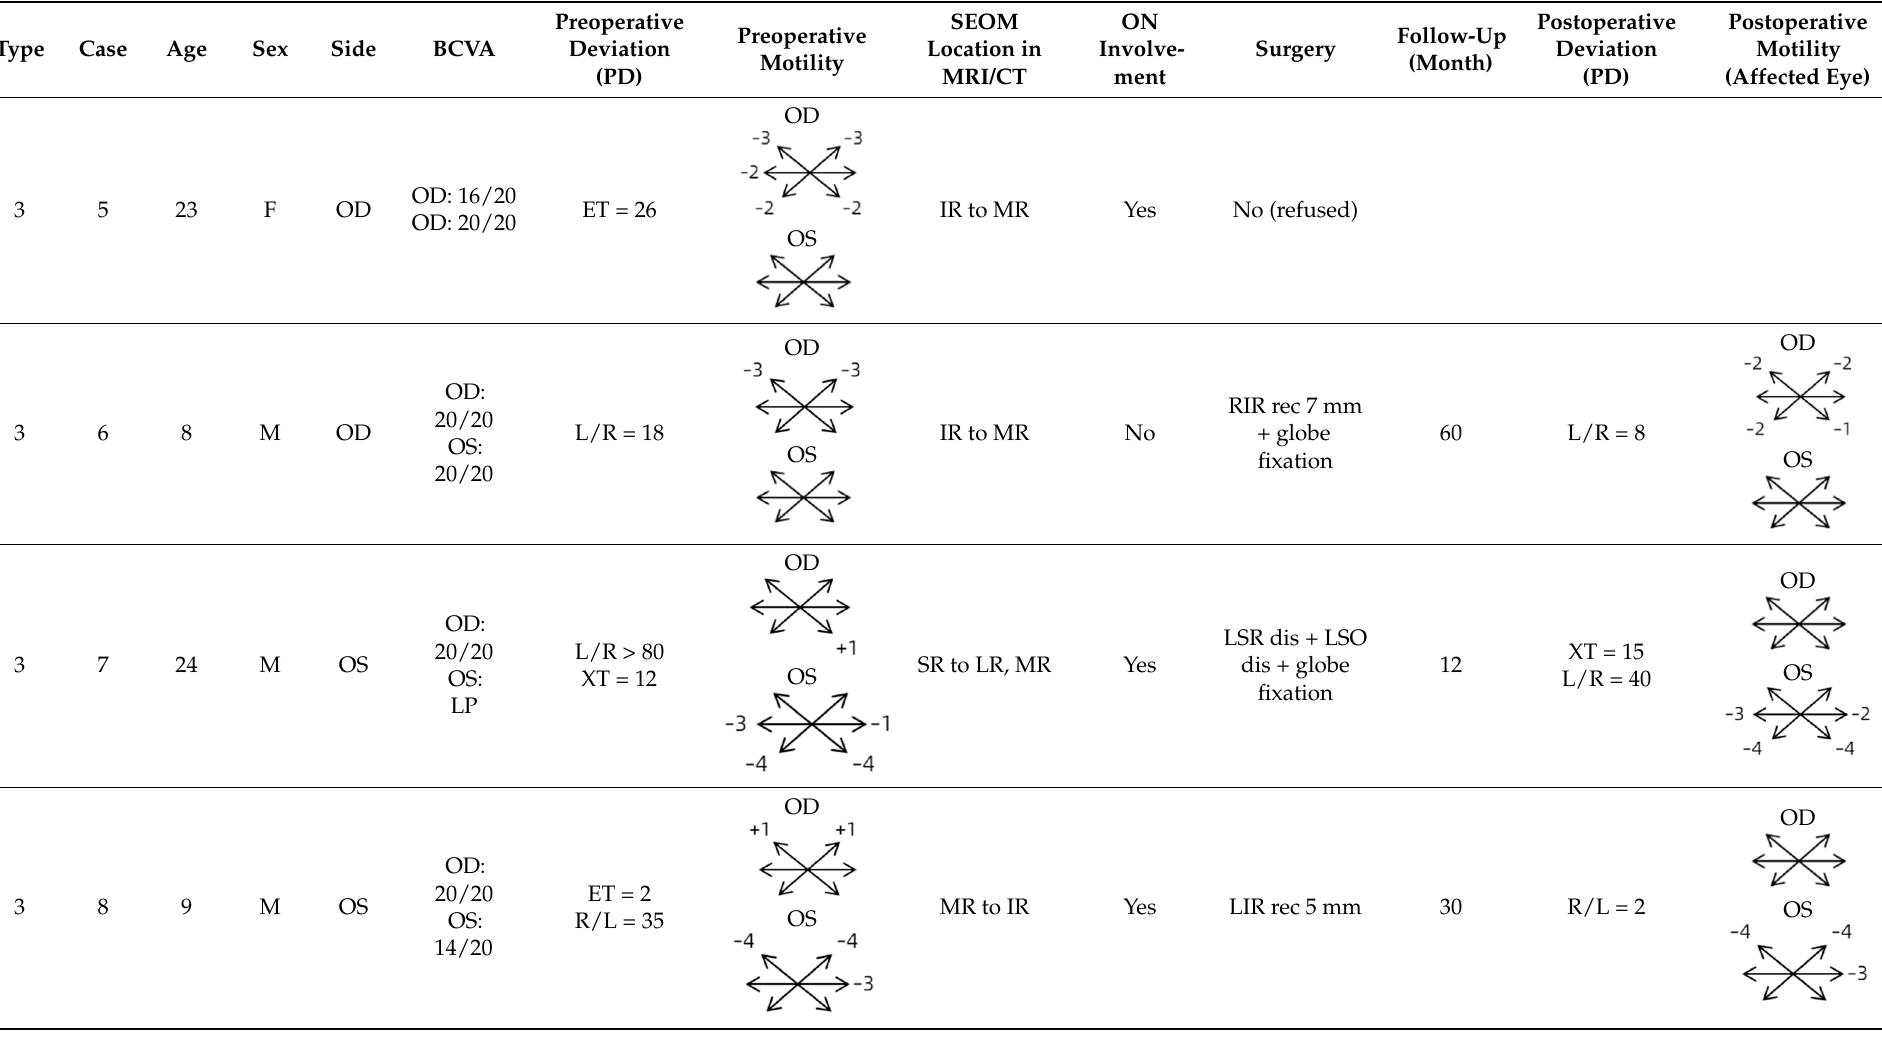
Table 1. Clinical characteristics and surgical results in 12 patients with supernumerary extraocular muscle.